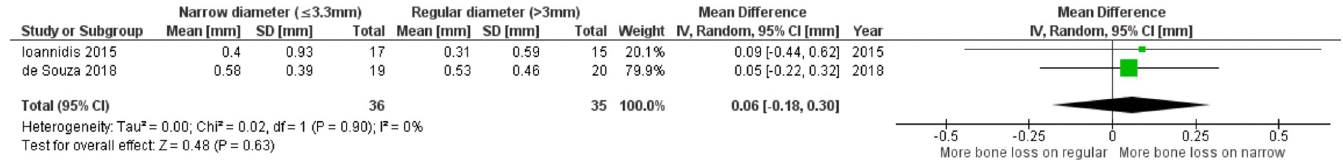
Fig 5. Forest plot of randomized clinical trials comparing marginal bone loss between narrow and standard implants.